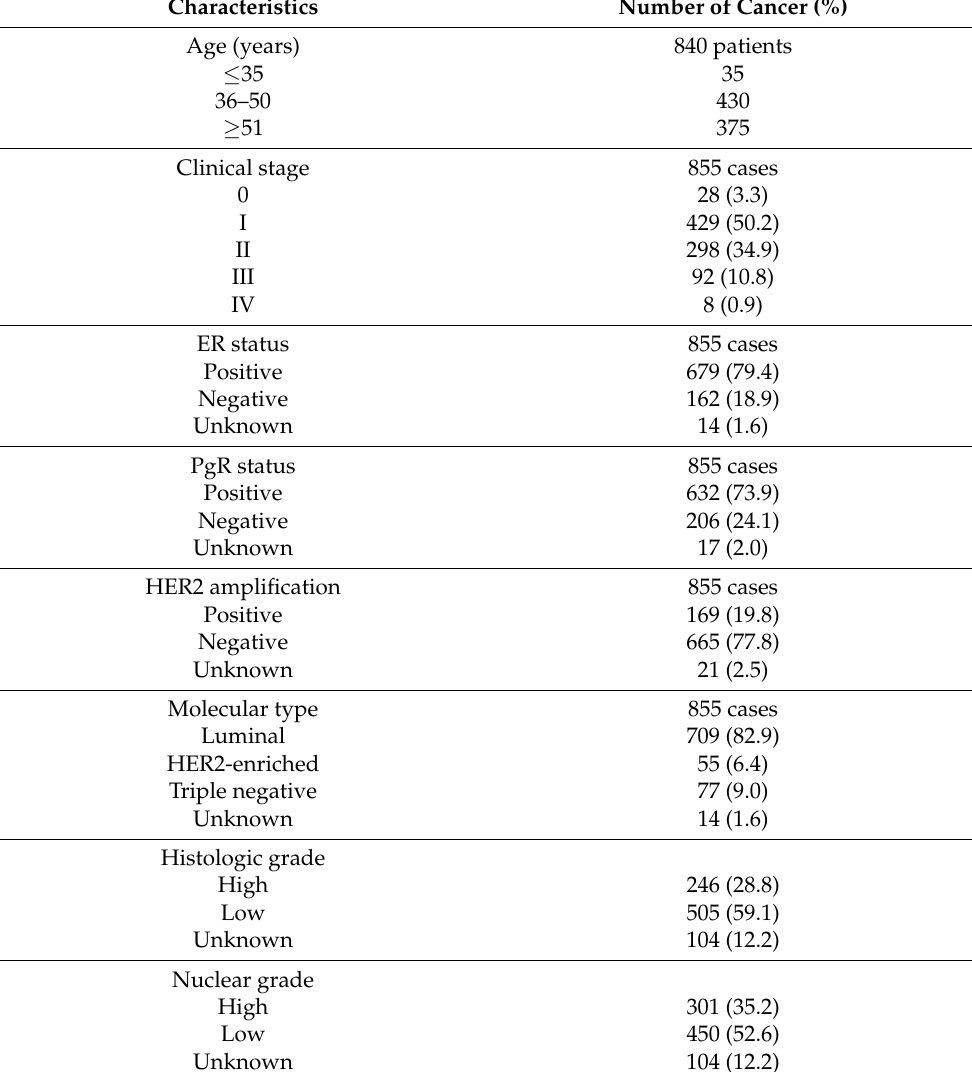
Table 1. Clinicopathologic characteristics of the 840 patients with 855 breast